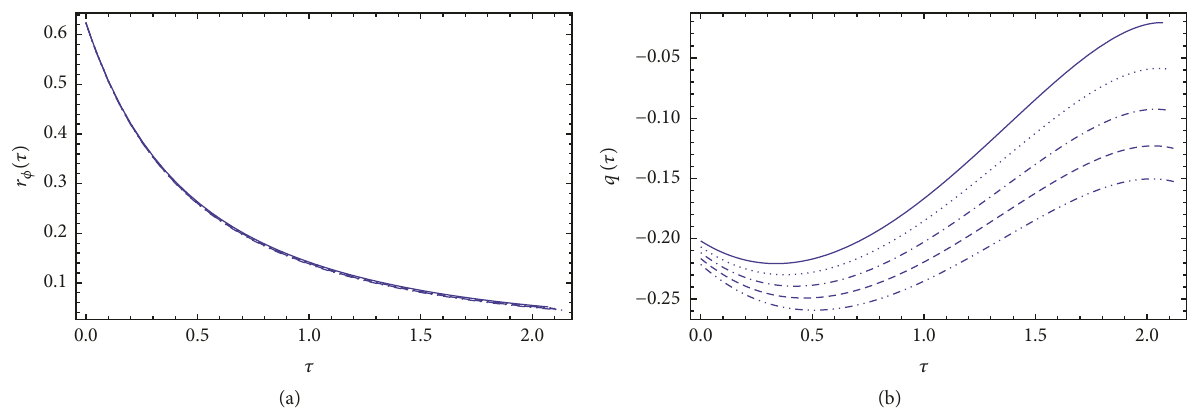
Figure 2: Time variation of the energy density of the scalar field (a) and of the deceleration parameter (b) during the reheating period in the presence of a large-field polynomial potential, for different values 𝛼 𝜙 of the decay width of the scalar field: 𝛼 𝜙 = 0.01 (solid curve), 𝛼 𝜙 = 0.03 (dotted curve), 𝛼 𝜙 = 0.05 (dash dotted curve), 𝛼 𝜙 = 0.07 (dashed curve), and 𝛼 𝜙 = 0.09 (dash double dotted curve), respectively. For 𝑝 we have adopted the value 𝑝 = 1.8 , while 𝜇 = 3.5 . The initial conditions used to numerically integrate (92) are 𝜙(0) = 1.1 , 𝑢(0) = −1 , 𝑁 𝜙 (0) = 3 , 𝑟 (0) = 0 , and 𝑟 (0) = 0 , DM m